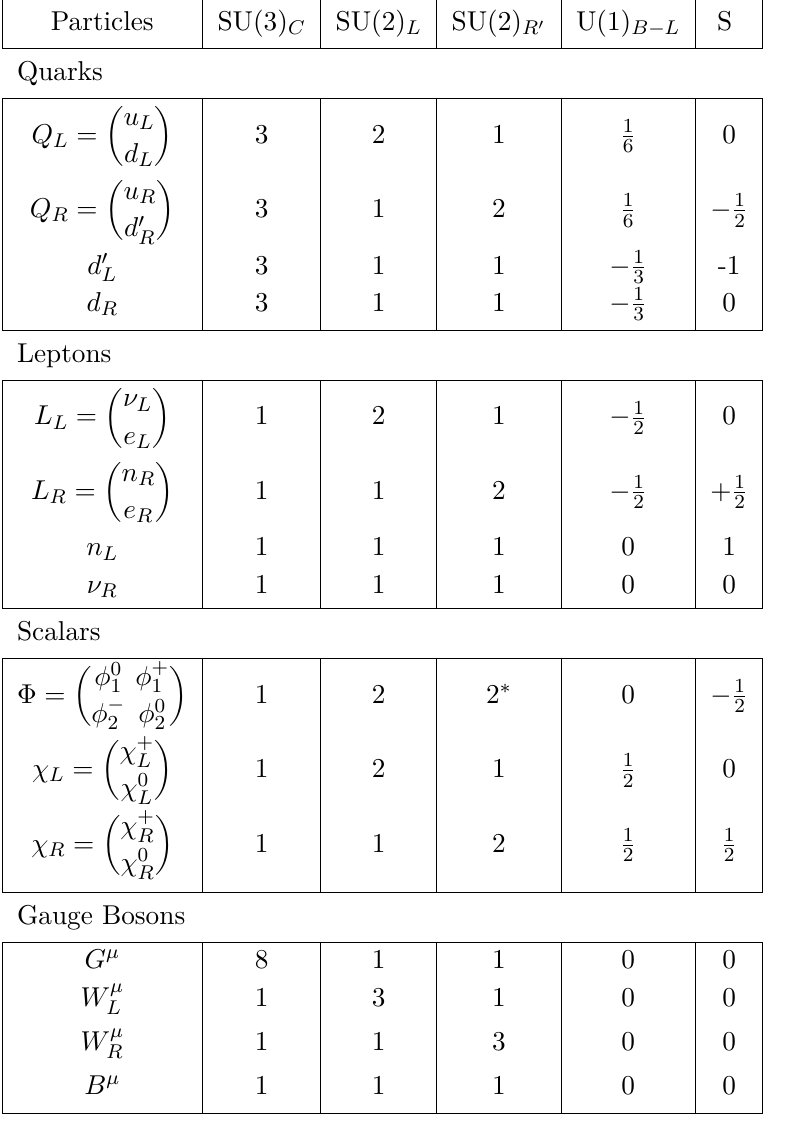
Table 1 . Particle content of